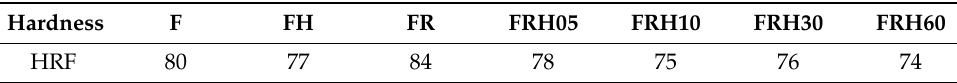
Table 1. Hardness of ZKX500 specimens.